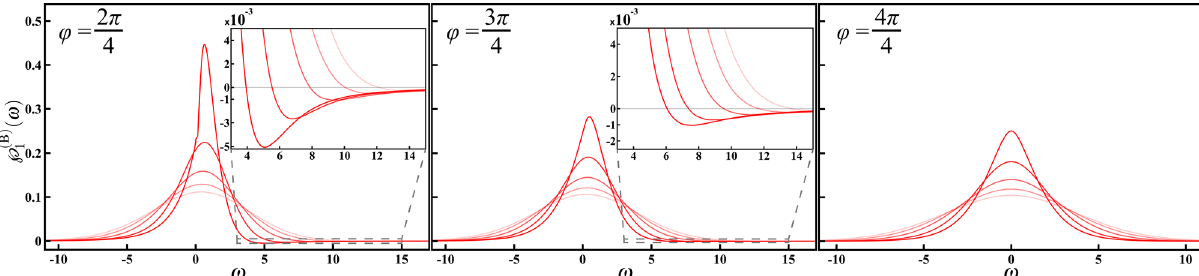
Figure 4. The CHER of the biased spin-boson model. We investigate the nonclassical effects of the relative phase ϕ between the two coupling constants under the balanced condition. In the left ( ϕ 3 π/ 4 ) panels, we can see shallow, and stretched, negative wings, which are further enlarged in the insets. ( ϕ = As T increases, the CHER broadens, and the negative wing gradually fades away. As ϕ approaching π (from left, middle, to right panels), it recovers the conventional model, and, consequently, the CHER for ϕ In these plots, we have assumed ω